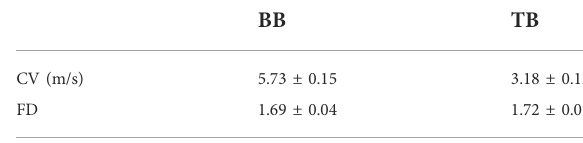
TABLE 1 Initial values of muscle fi ber CV and FD during the sustained fatiguing